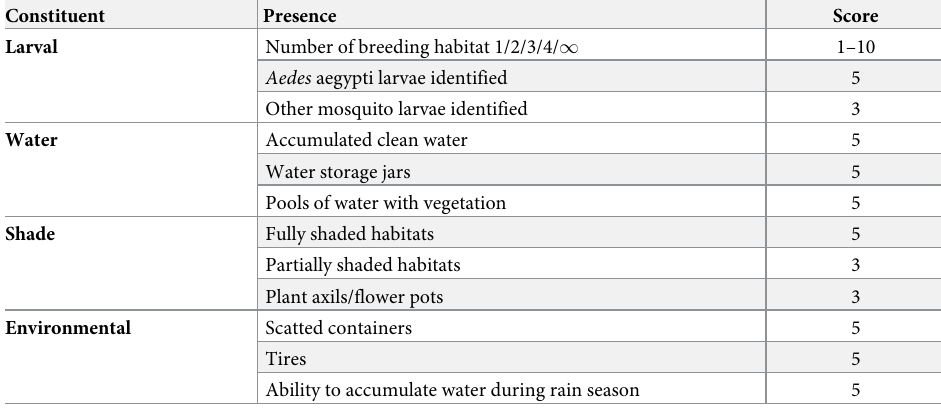
Table 1. Aedes aegypti breeding habitat suitability scores among houses with confirmed dengue